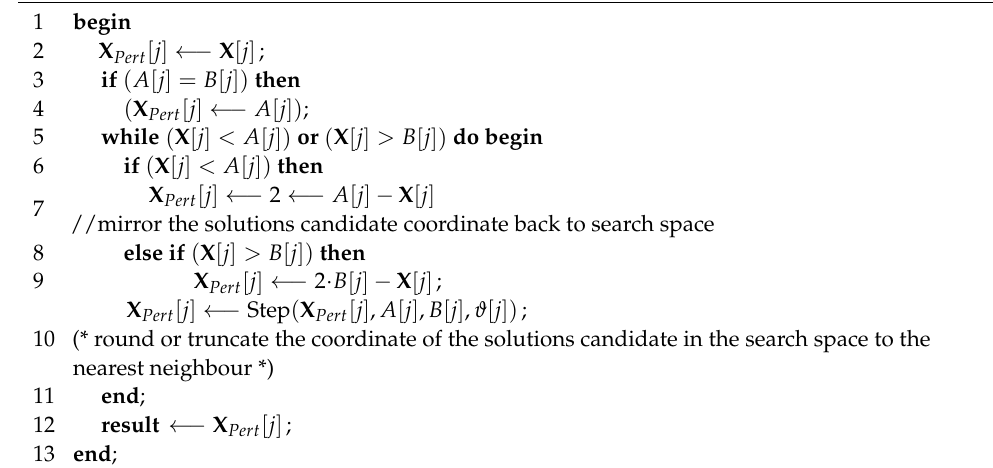
Algorithm 2: Perturbation